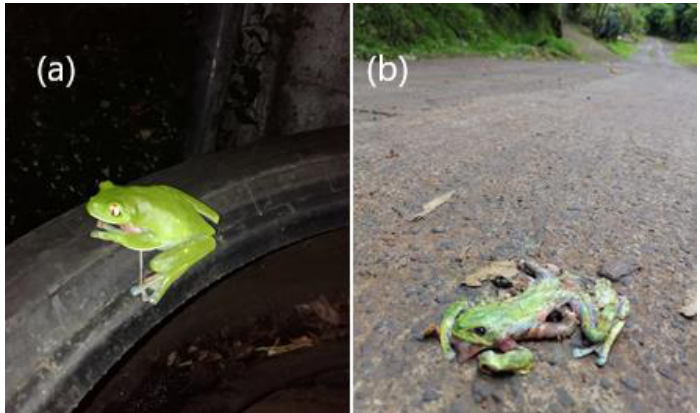
Figure 5. Blue-sided treefrog ( Agalychnis annae ); ( a ) use of artificial containers in urban environments as breeding/foraging sites (picture, Kathia Alfaro); ( b ) roadkill in an urban area of the province of San Jose, Costa Rica (picture, Gustavo Murillo and Naomi Méndez). Reproduced with permission from Kathia Alfaro, Gustavo Murillo and Naomi Méndez.